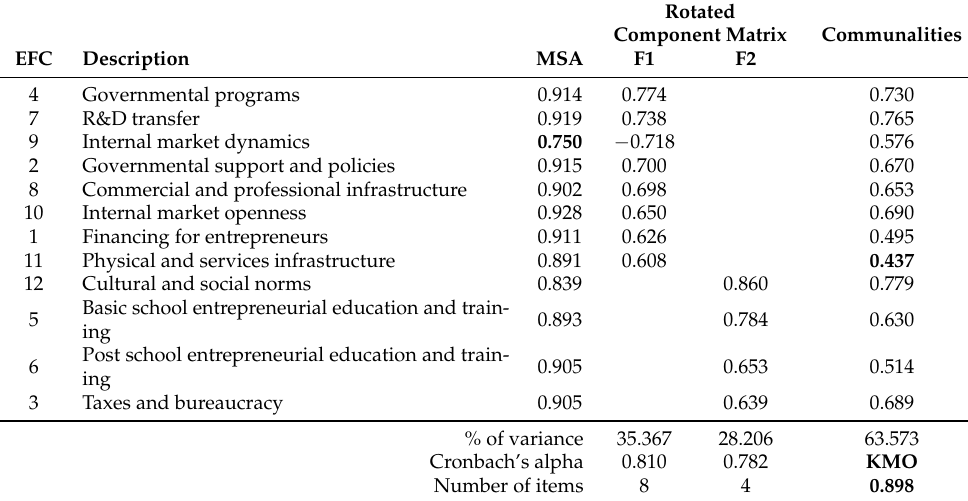
Table 2. Factor analysis—full data set: 2000–2019.